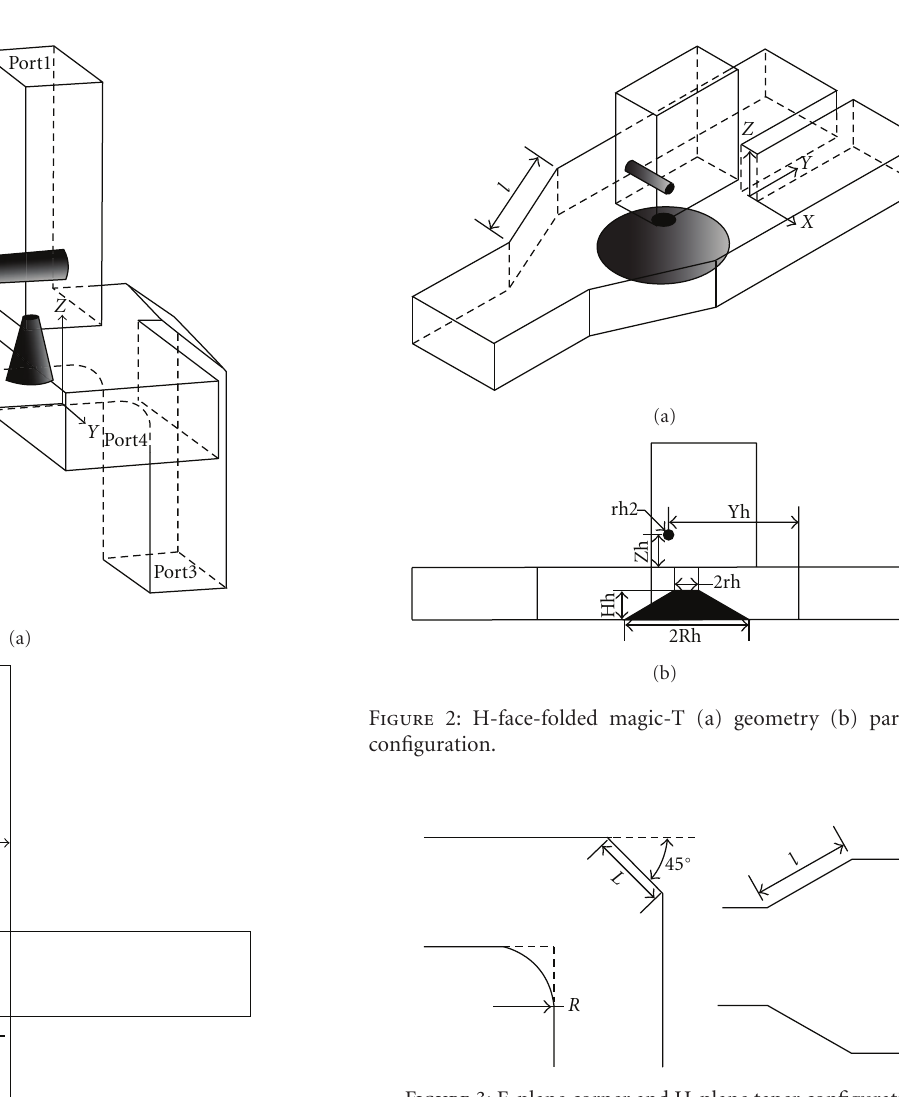
Figure 3: E-plane corner and H-plane taper configuration.